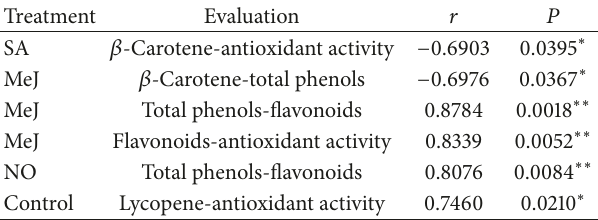
∗ and ∗∗ indicate significance at 𝑃 ≤ 0.05 or 𝑃 ≤ 0.01,